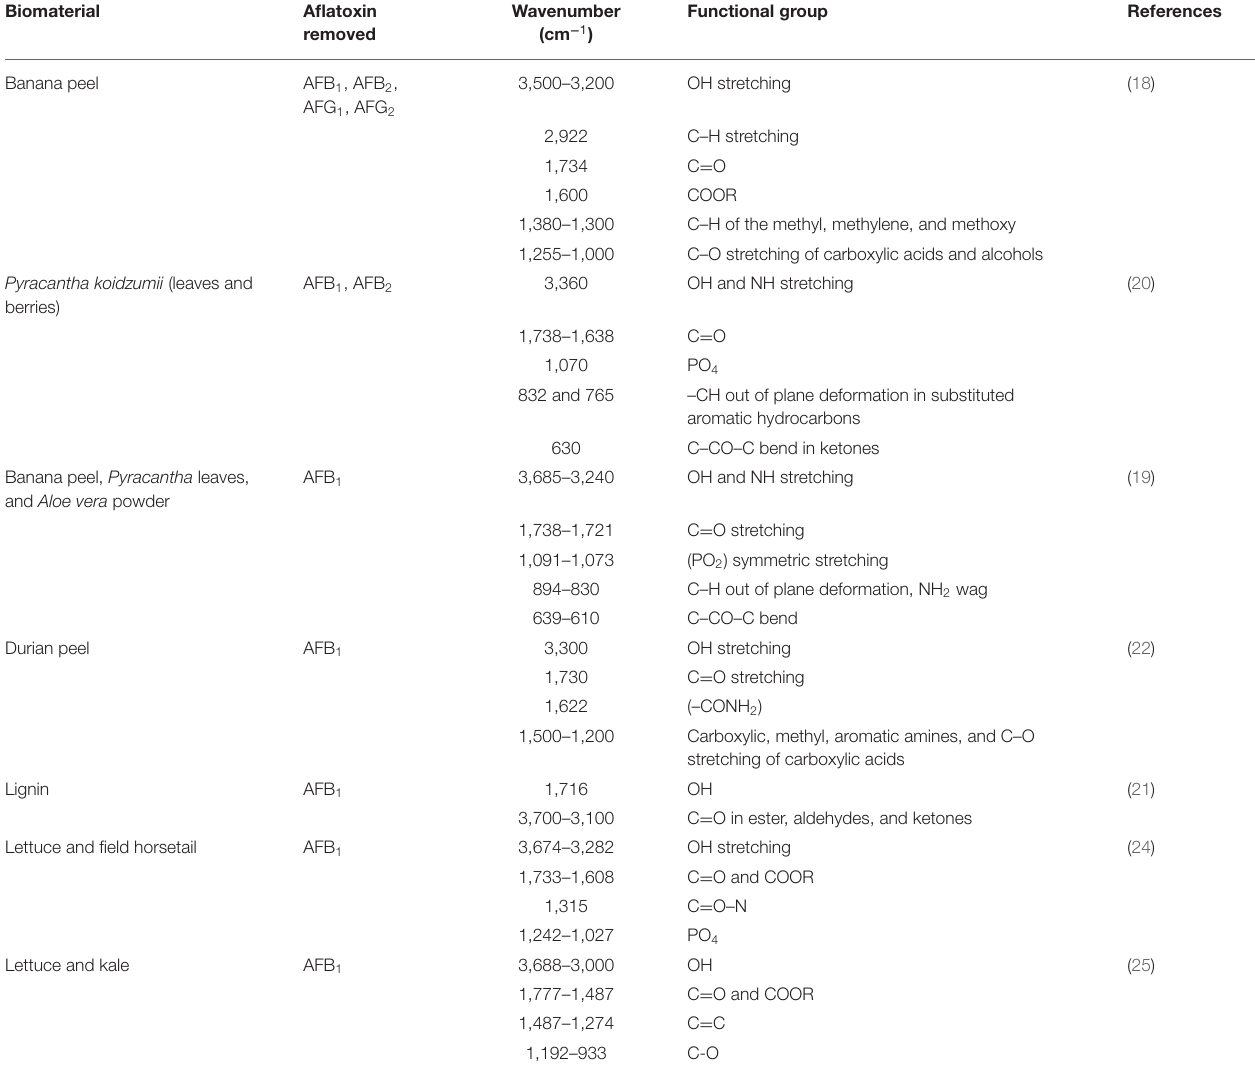
TABLE 3 | Overview of the most relevant chemical functional groups responsible for the biosorption of aflatoxins.